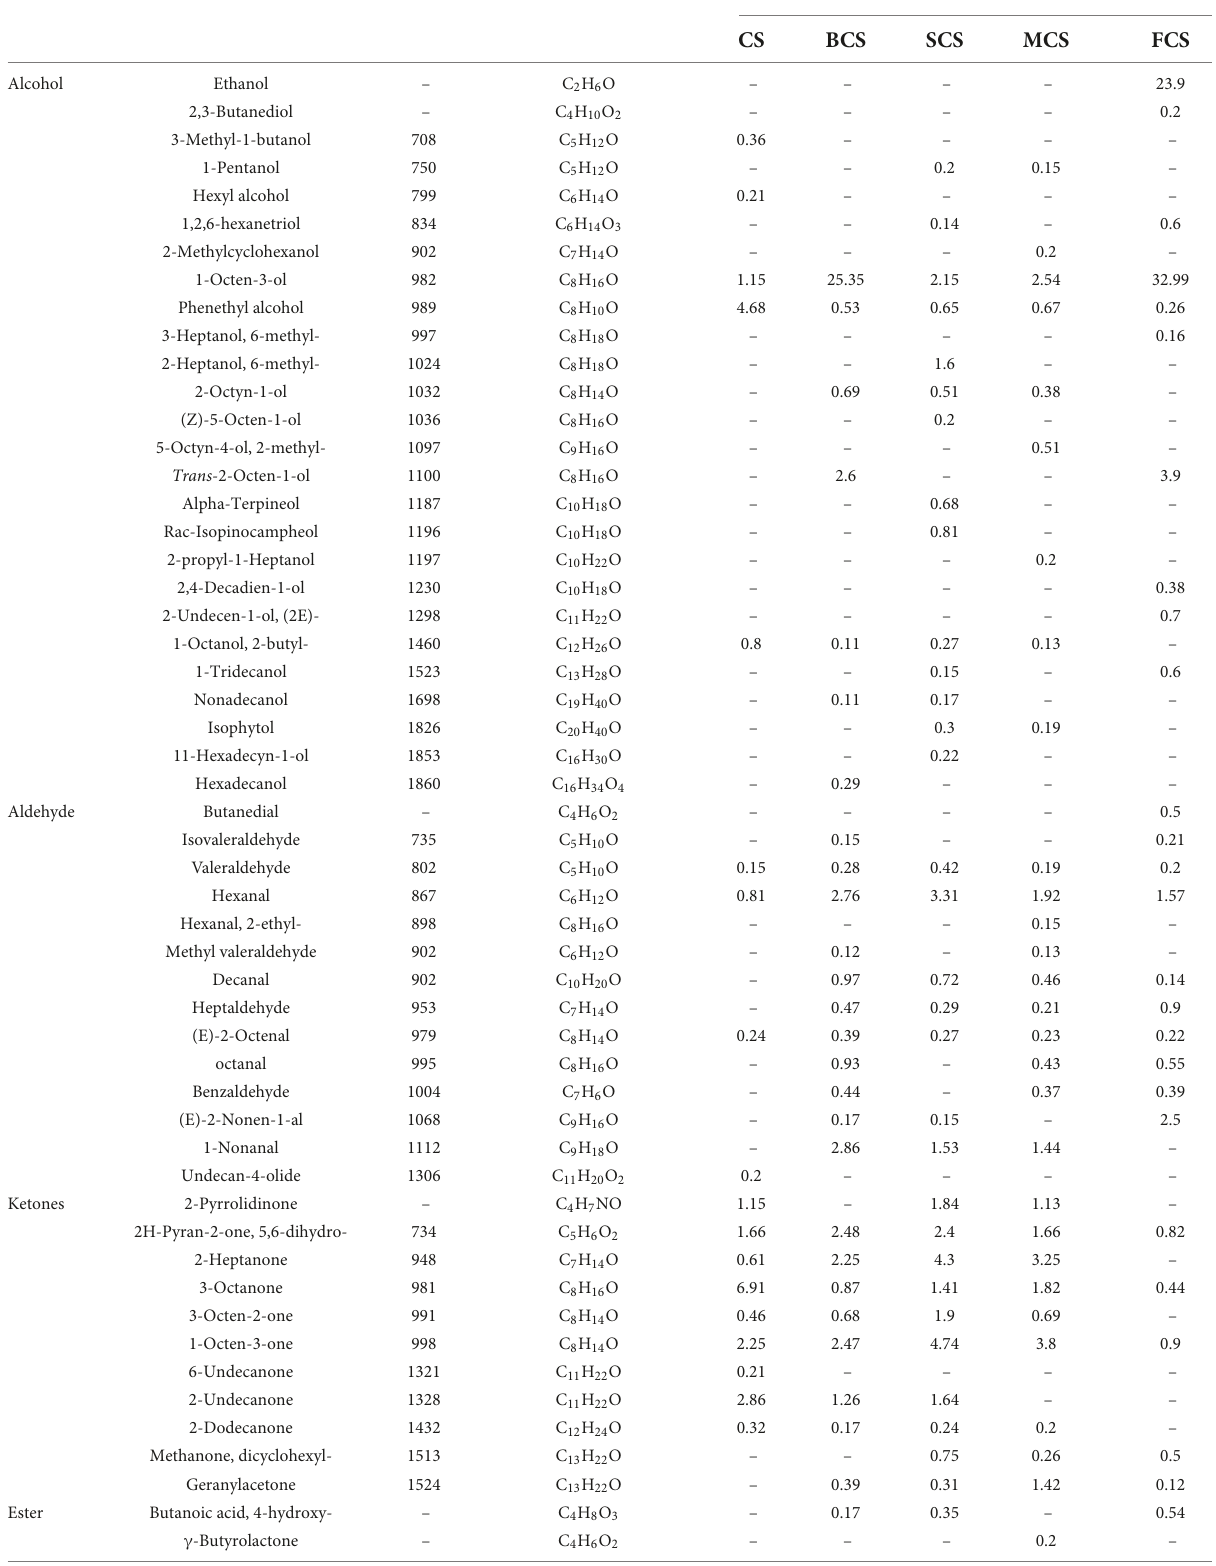
TABLE 1 Relative contents of volatile compounds in C. squamulosa with different cooking methods. English